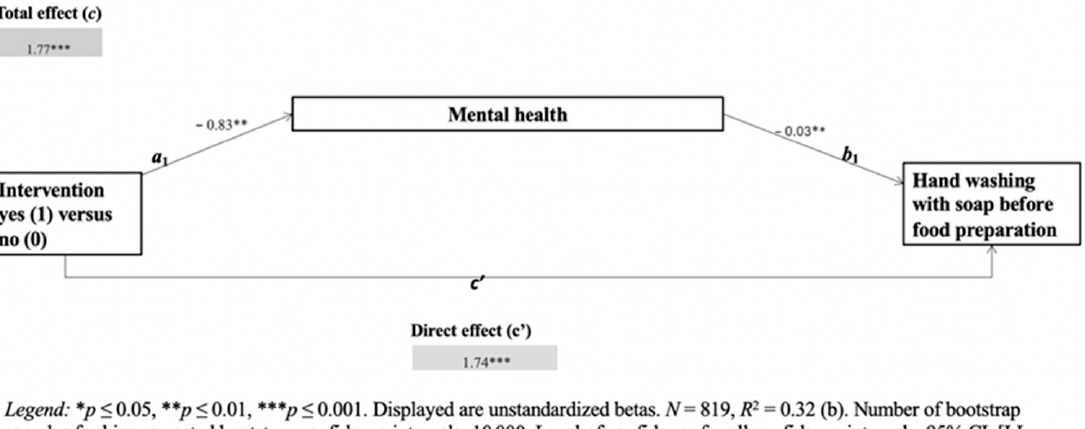
Figure 1. Mediation analysis: effects of intervention on handwashing at key times via mental health (mediator).